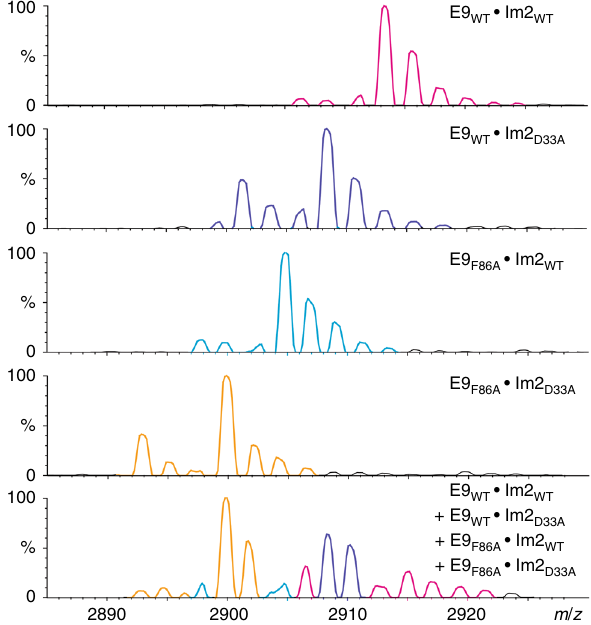
Fig. 4 Interaction of Phe86 in E9 with Asp33 in Im2 studied by native MS. Representative mass spectra of the +9 charge state are shown for the